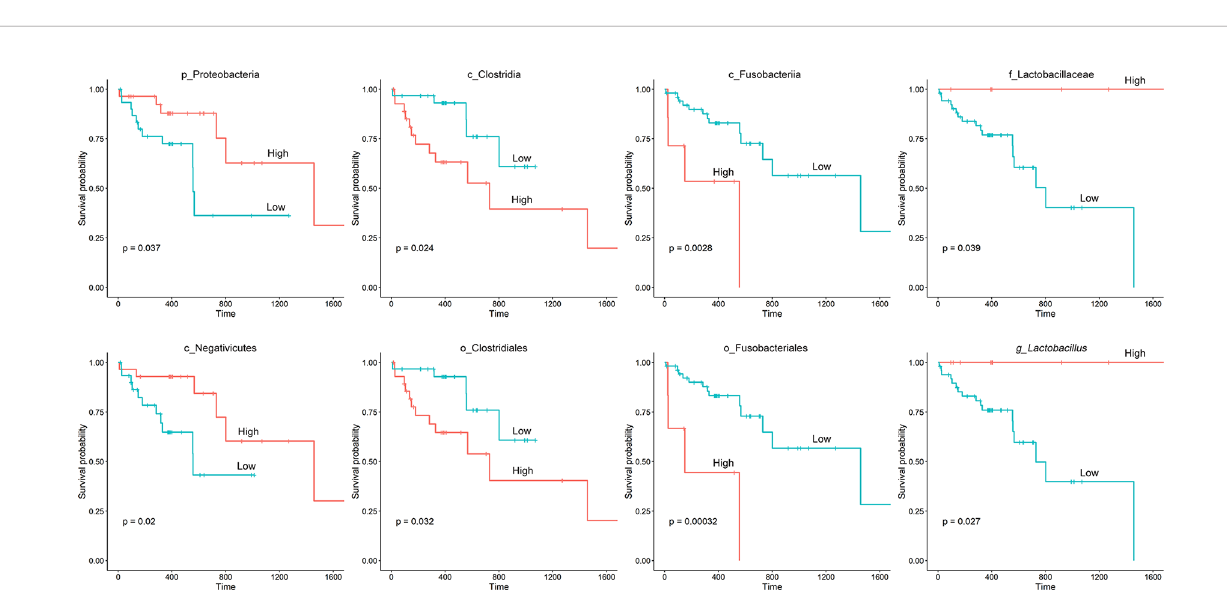
FIGURE 5 | Kaplan ‐ Meier survival curves based on microbial composition. The “ survival ” and “ survminer ” packages in R were used for survival analysis. The process included determining the optimal cut-off point of variables, categorizing variables into “ high ” and “ low ” subgroups based on microbial abundance, fi tting survival curves and visualization.